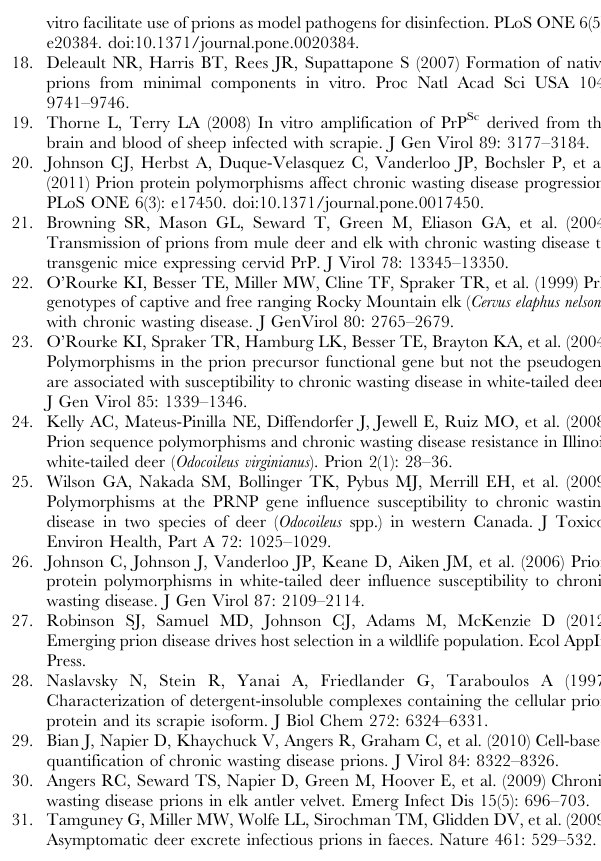
Figure S2 Teflon beads allow the largest amplification of CWD associated PrP res during PMCAb. Teflon beads were tested against beads of other material (all 2.38 mm) in one round of PMCAb consisting of 96 cycles. CWD +